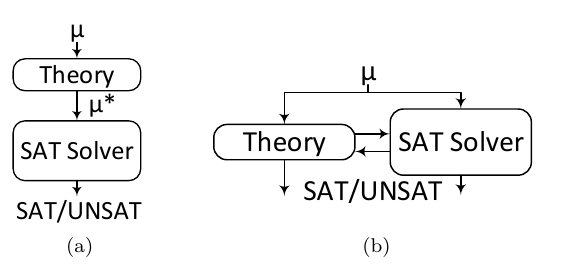
Figure 7: Execution Flow of (a) SMT Eager vs. (b) SMT Lazy approach